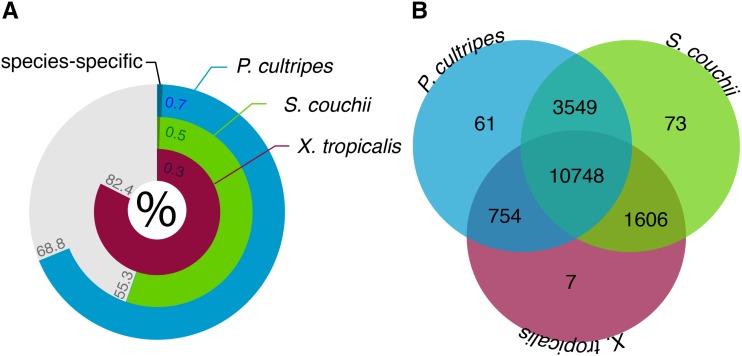
OrthoFinder results showing a) the percentage of genes that could be assigned to orthogroups per species (darker shading represents percentage of genes in species-specific orthogroups) and b) the number of species-specific and shared orthogroups recovered.